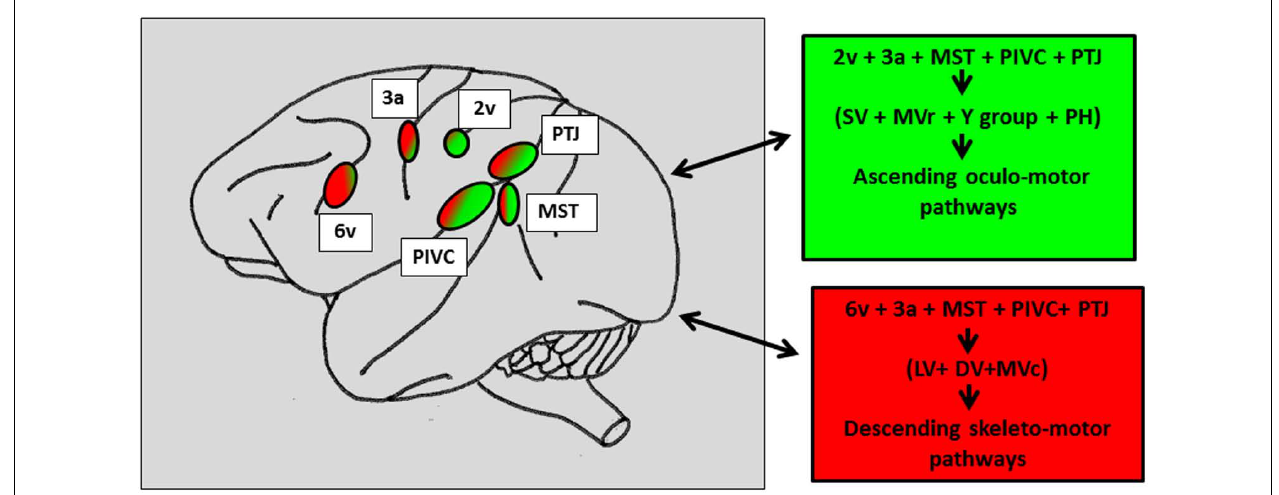
FIGURE 5 | Schematic representation of the vestibular cortical sites directly connected to the vestibular nuclei and the prepositus hypoglossi in macaque brain. In the right panels: Projections topographically organized with the caudal vestibular cortical fields including MST, RI, andTPJ projecting more in the vestibular and prepositus hypoglossi nuclei, involved in the oculomotor ascending pathways (green patches) as compared to the more rostral cortical fields connected to the vestibular nuclei mainly involved in the